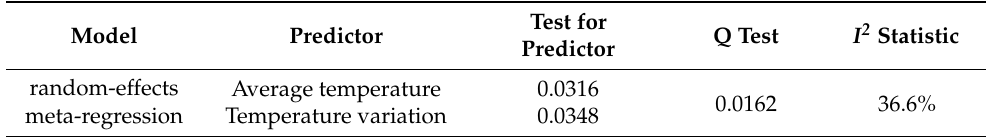
Table 3. Second-stage random-effects meta-regression models. Model